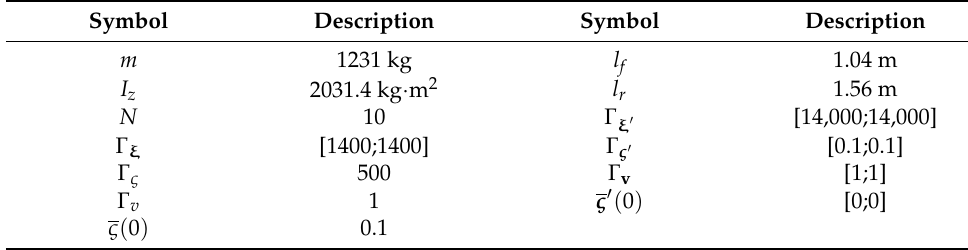
Figure 6. Simulation structure. Table 5. Parameters of CarSim and estimators.